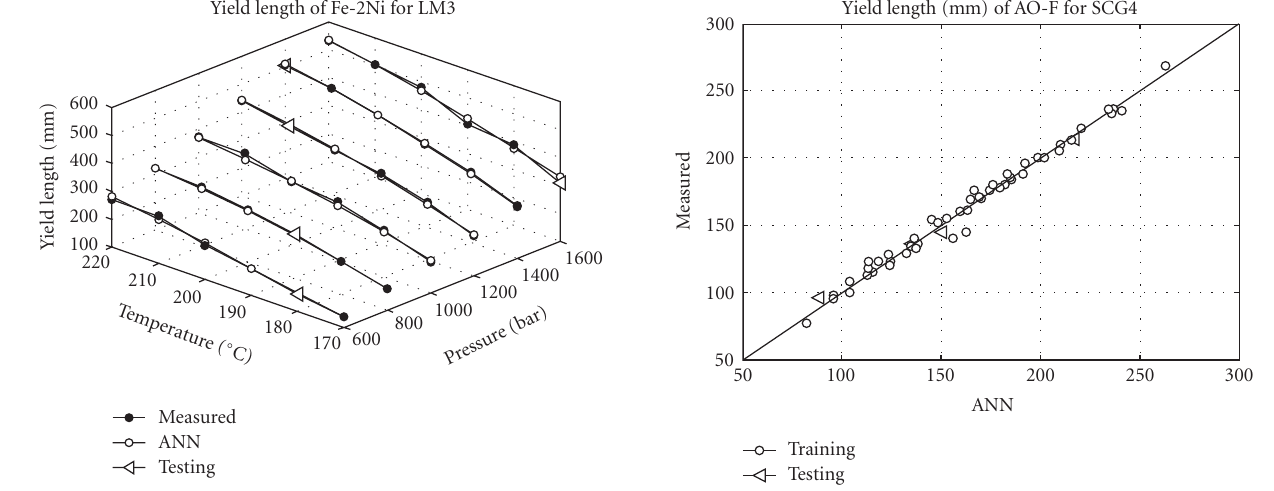
Figure 19: Comparison of the measured and predicted yield length for A0-F.